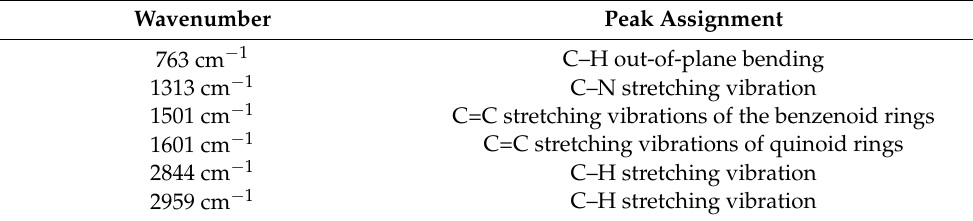
Figure 9. FTIR spectra of PANI thin films prepared by APPR with pin electrode under optimal conditions with respect to three electrode configurations (cases I, II, and III). Table 4. Comparison of FTIR spectra of PANI thin films deposited by APPR with pin electrode under optimal conditions with respect to three electrode configurations (cases I, II, and III) obtained from FTIR spectra of PANI thin films in Figure 9.